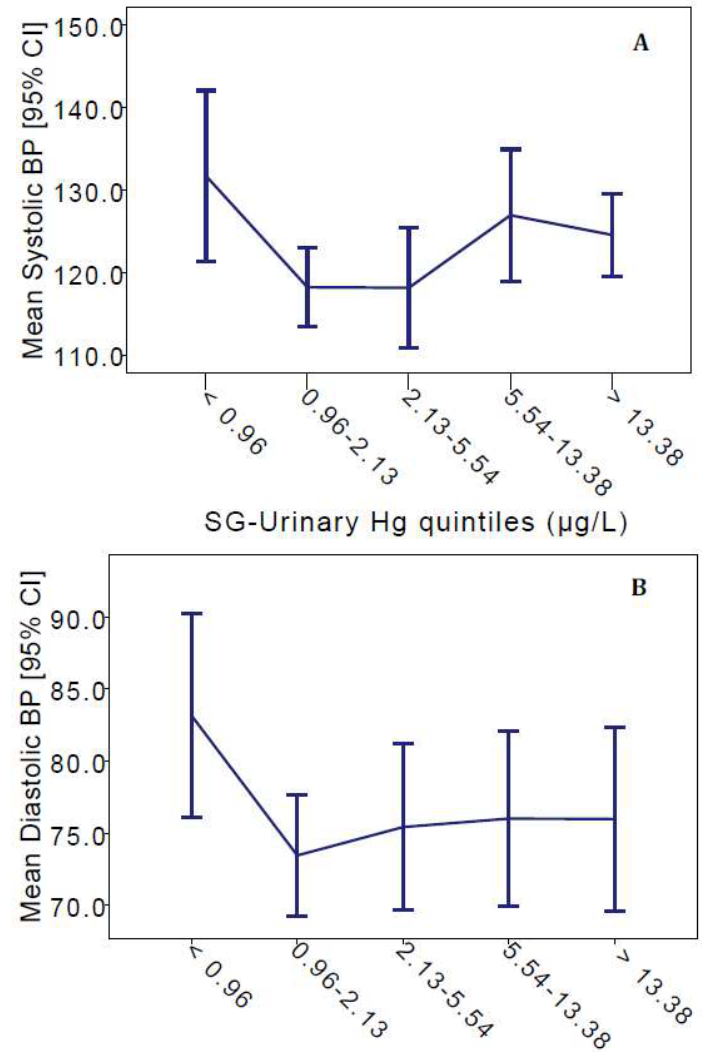
Figure 2. Mean systolic ( A ) and diastolic BP ( B ) by quintiles of SG-adjusted urinary Hg concentrations in Kejetia. Error bars represent 95% confidence